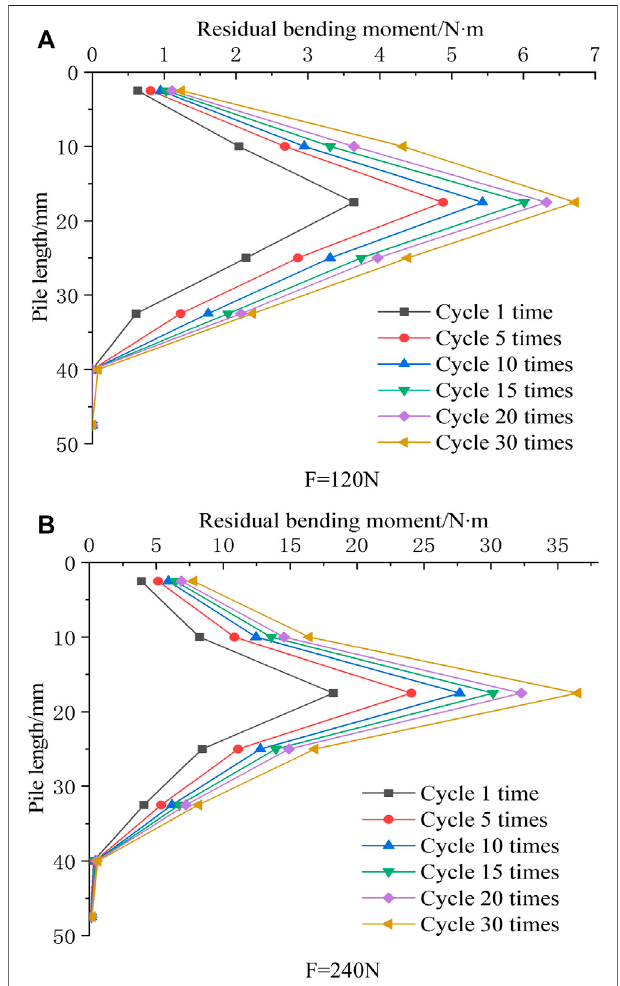
FIGURE 18 | Residual bending moment distribution diagram of composite foundation pile under horizontal cyclic load. (A) Distribution diagramofresidualbendingmomentwhenF=120N. (B) Distributiondiagram of residual bending moment when F = 240N.